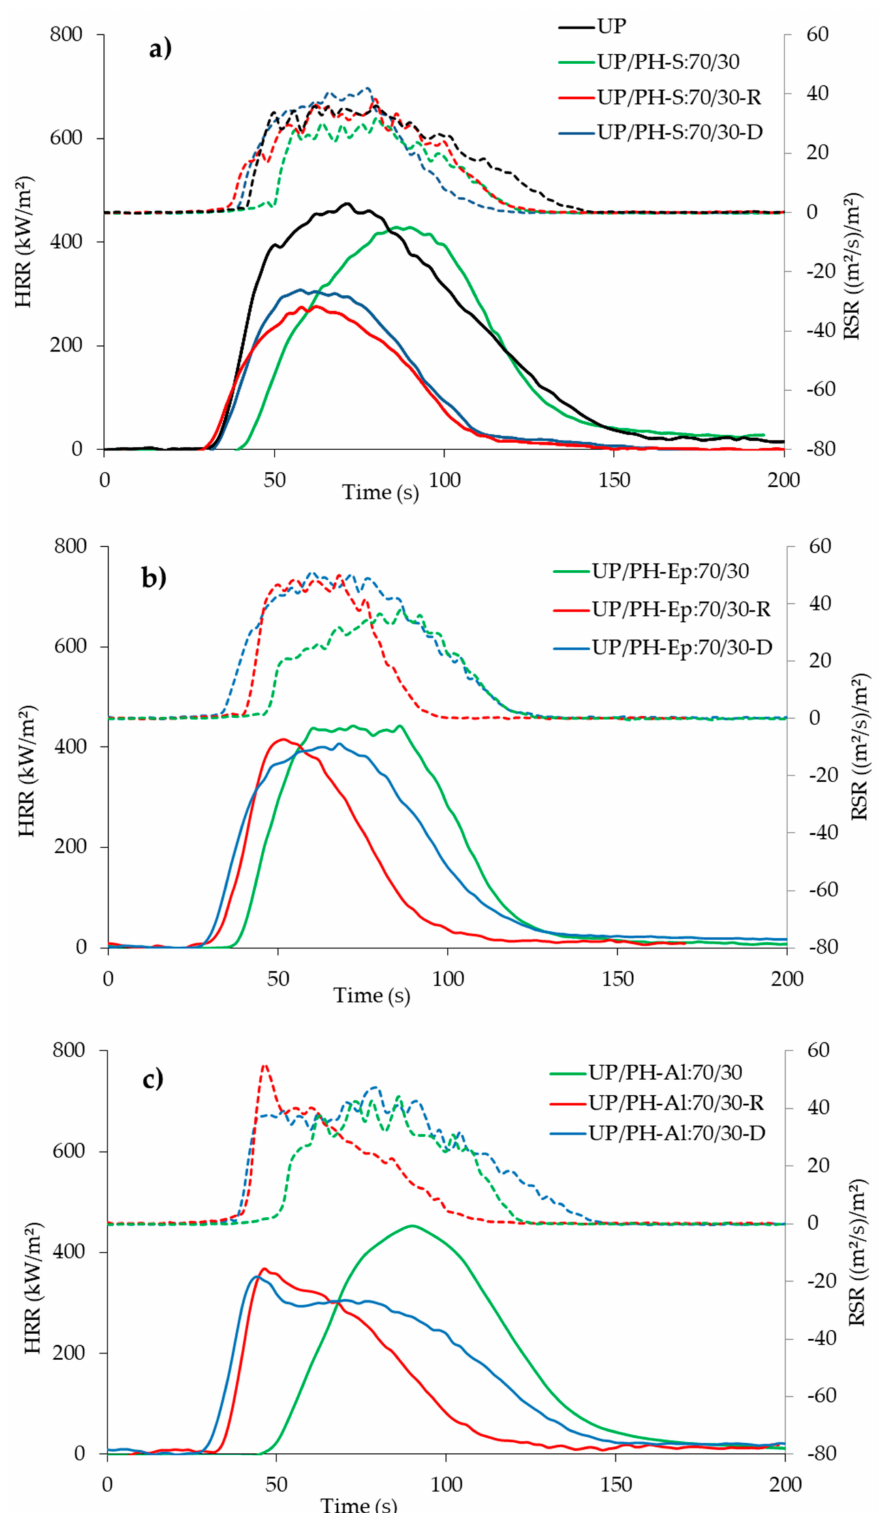
Figure 1. ( a – c ) HRR vs. Time (solid lines) and RSR vs. Time (broken lines) curves of UP/PH-S, UP/PH-Ep and UP/PH-Al GFRC samples at 50 kW/m 2 heat